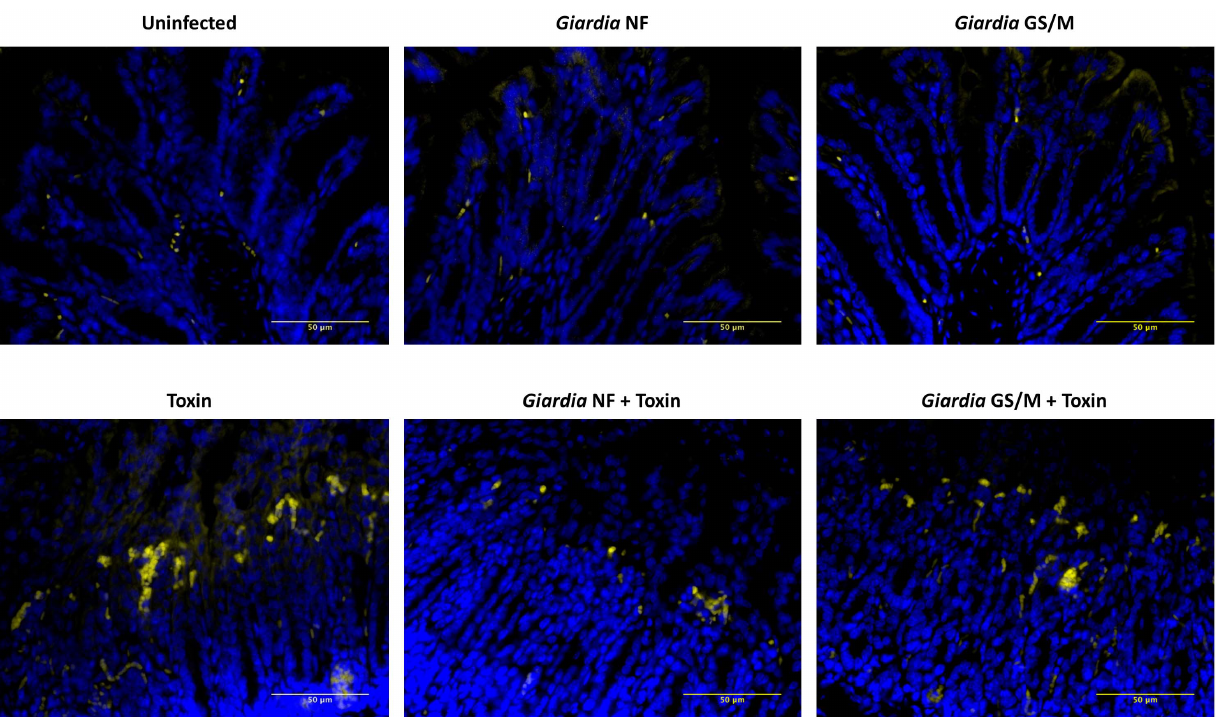
Figure 2. Giardia NF-infected animals exhibit reduced MPO-positive cells following administration of C.difficile TcdAB. Male C57BL/6 mice aged 4 to 6 weeks were infected with Giardia NF or GS/M trophozoites. 7 days post-infection, animals were given 100 m g of TcdAB or PBS i.r. and, after 3 hours, animals were euthanized. Representative immunohistochemical images of MPO-positive cells (yellow) counterstained with DAPI (blue) in colonic tissues of uninfected animals or animals infected with Giardia NF or GS/M trophozoites following i.r. instillation of 100 m g TcdAB or PBS. All data are representative of two independent experiments (n=5–11/group) and taken at the same magnification (400 6 ). Bars equal 50 m m for all